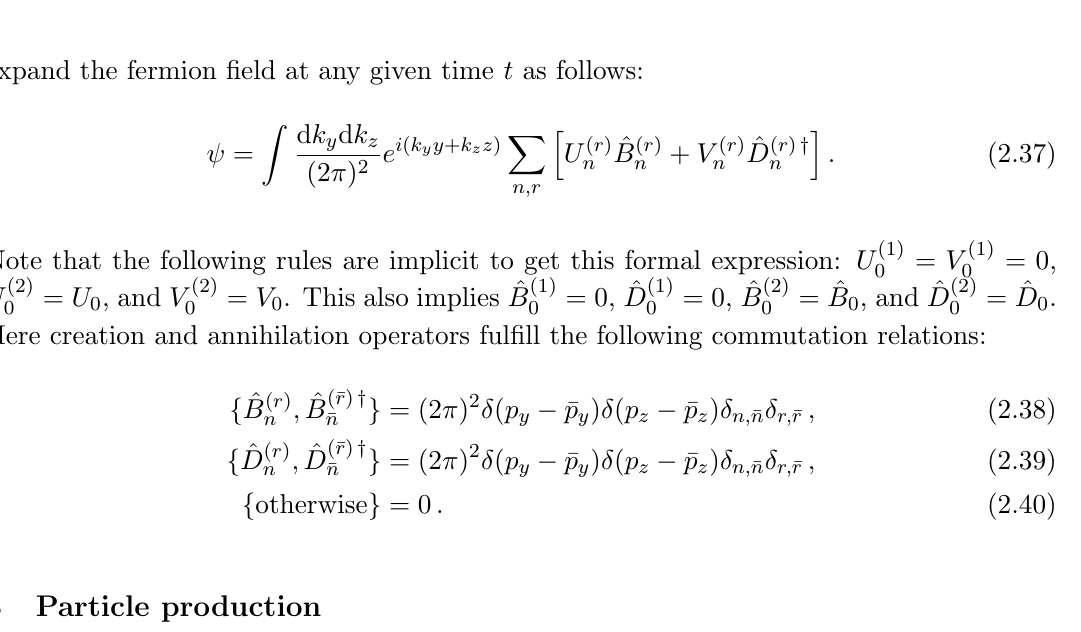
Figure 2 . A schematic plot of the time evolution of the electric (cid:12)eld, see eq. (3.1). Here we work p in units of g j Q j E = 1 with E being a constant value of the electric (cid:12)eld for t = 0 to (cid:28) . In this plot, we have set (cid:28) =